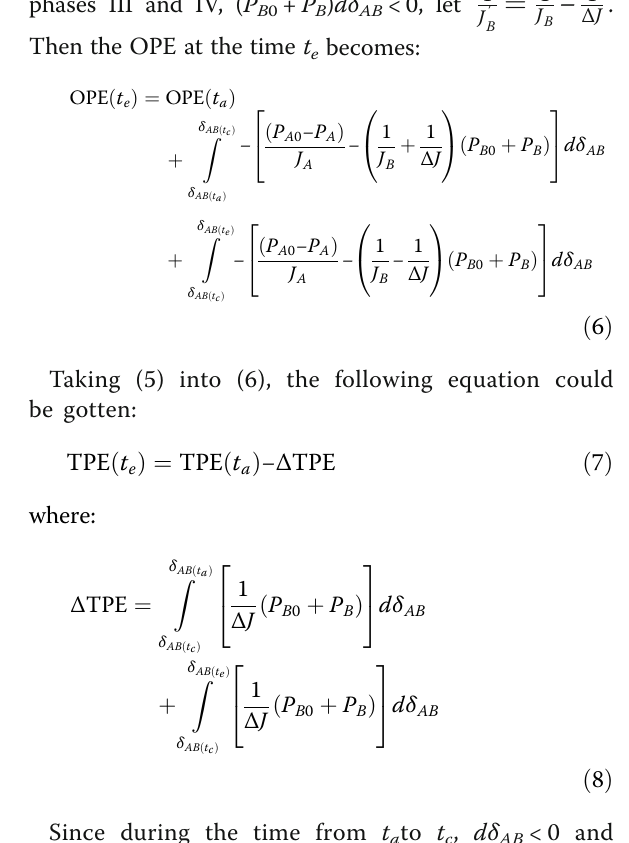
Fig. 5 Power oscillation of the tie line after